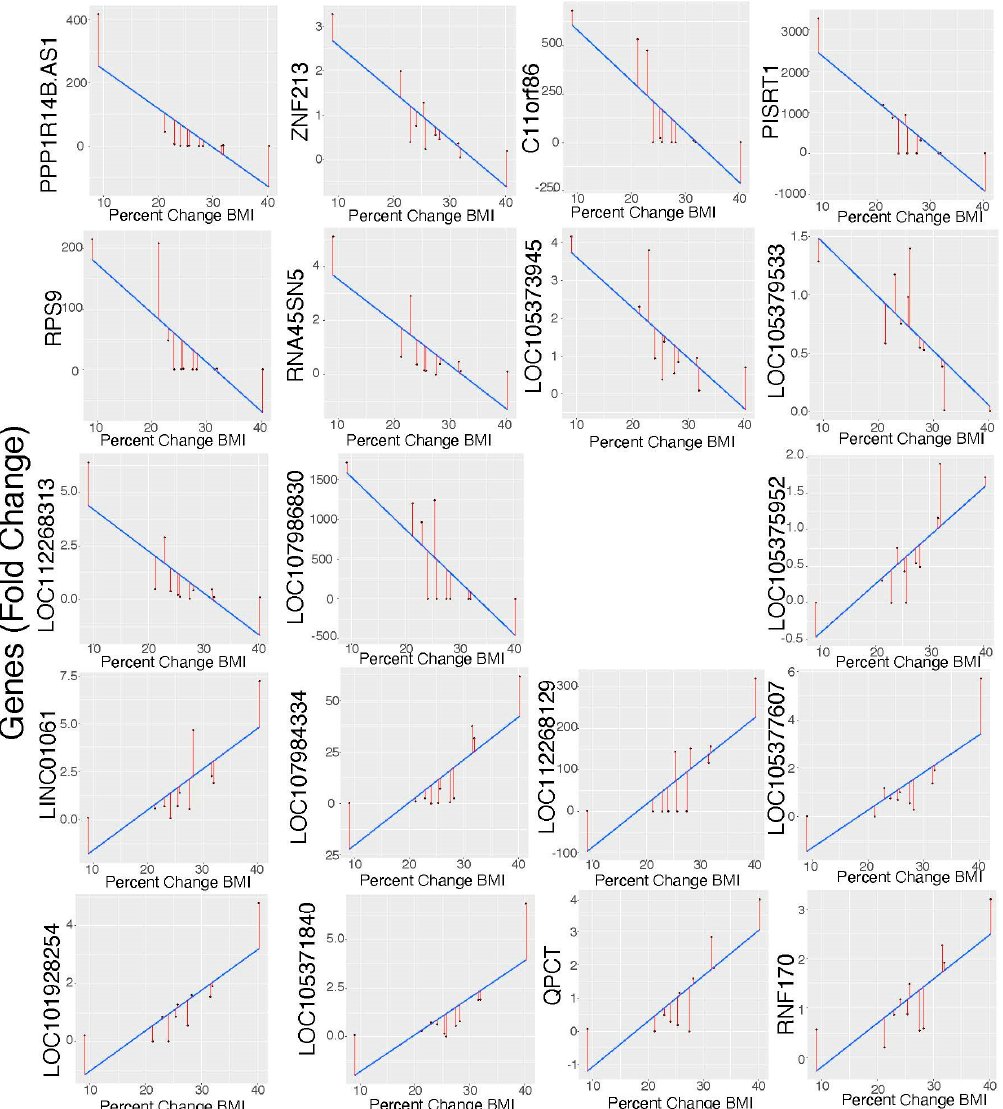
Figure 4. Linear relationship between gene expression fold change and percentage change in BMI. Each dot represents one patient. The blue line shows the linear relationship, and the red line shows the deviation from the blue line for each patient.